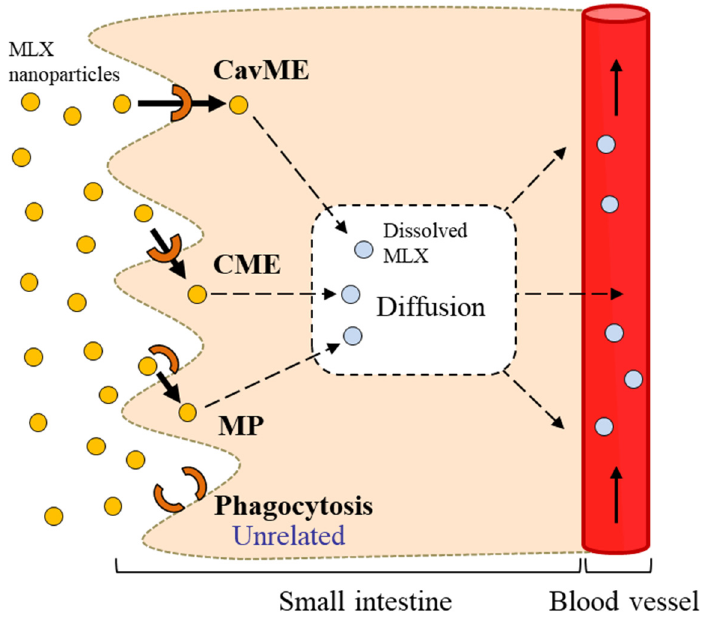
Figure 4. E ff ect of energy-dependent endocytosis on the intestinal penetration of MLX-NPs (0.2 mg / mL). ( A , B ) Intestinal penetration of MLX through the jejunum ( A ) and ileum ( B ) treated with MLX-NPs at 4 ◦ C and 37 ◦ C conditions. ( C , D ), changes in intestinal penetration profile ( C ) and AUC penetration ( D ) of MLX-NPs in the jejunum applied at low temperature or at normal temperature in the presence of various endocytosis inhibitors. ( E , F ), changes in intestinal penetration profile ( E ) and AUC penetration ( F ) of MLX-NPs in the ileum applied at low temperature or at normal temperature in the presence of various endocytosis inhibitors. n = 6–8. * P < 0.05 vs. 4 ◦ C (low temperature) for each category. # P < 0.05 vs. Vehicle for each category. The intestinal penetration of MLX-NPs was remarkably suppressed under low-temperature conditions, and at normal temperature by treatment with nystatin,